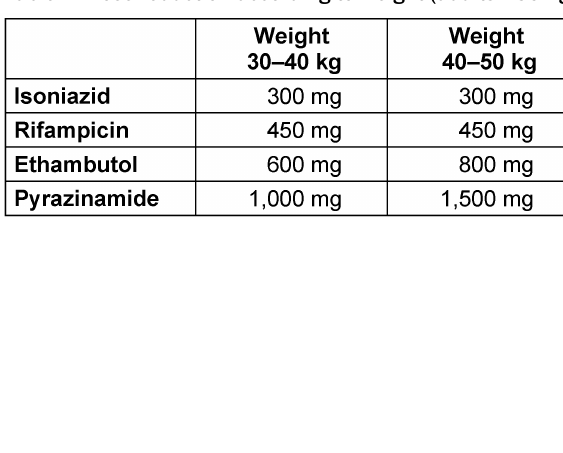
Table 2: Dose-reduction according to weight (adults <50